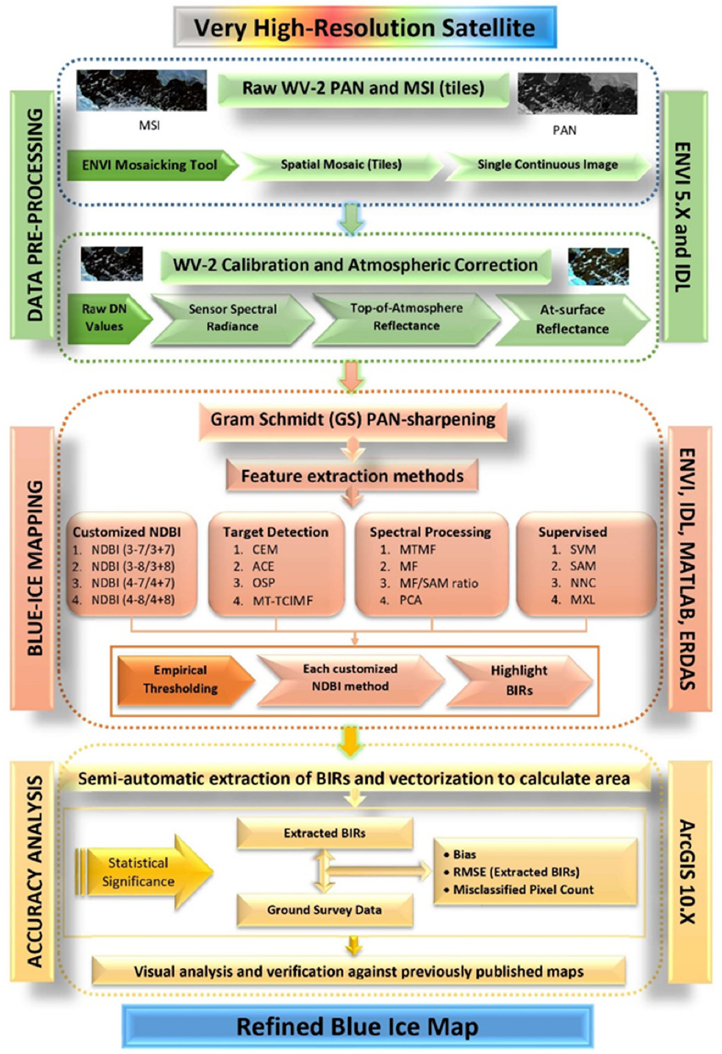
Figure 3. Experimental protocol for semi-automatic extraction of blue ice